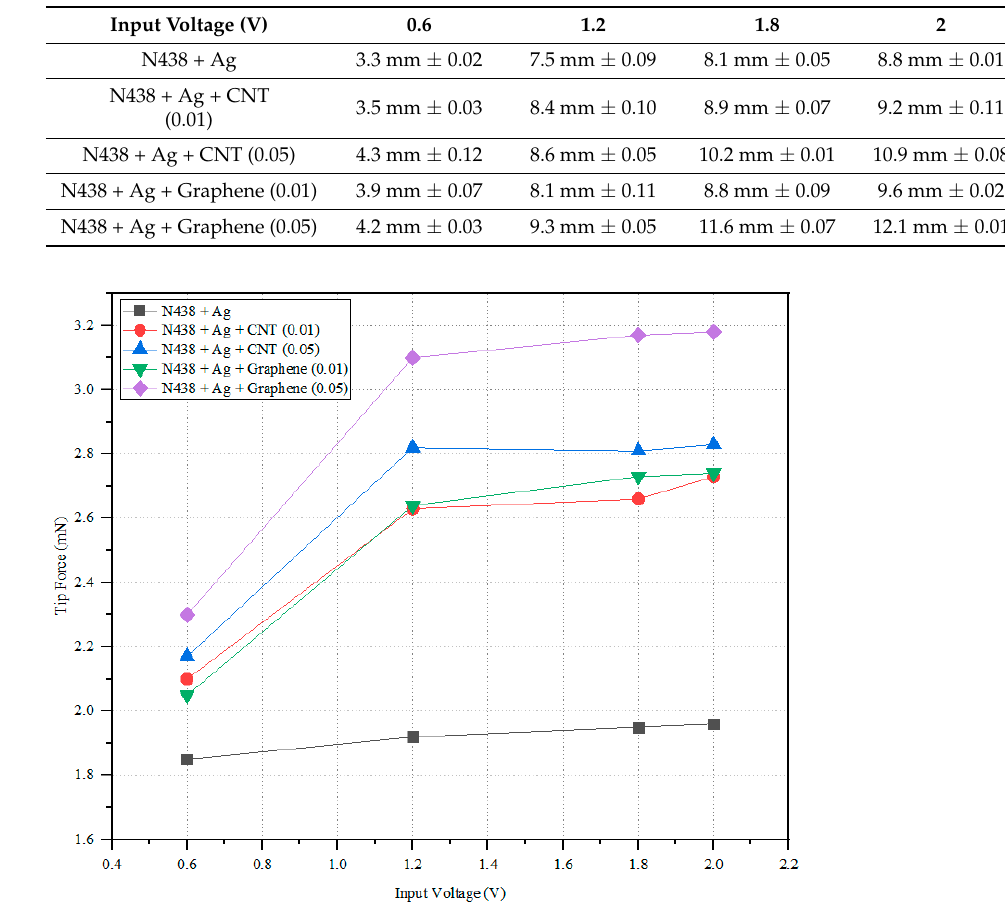
Figure 9. Input voltage vs. displacement. Table 5. Tip deflection of the IPMC membranes at different input voltages.